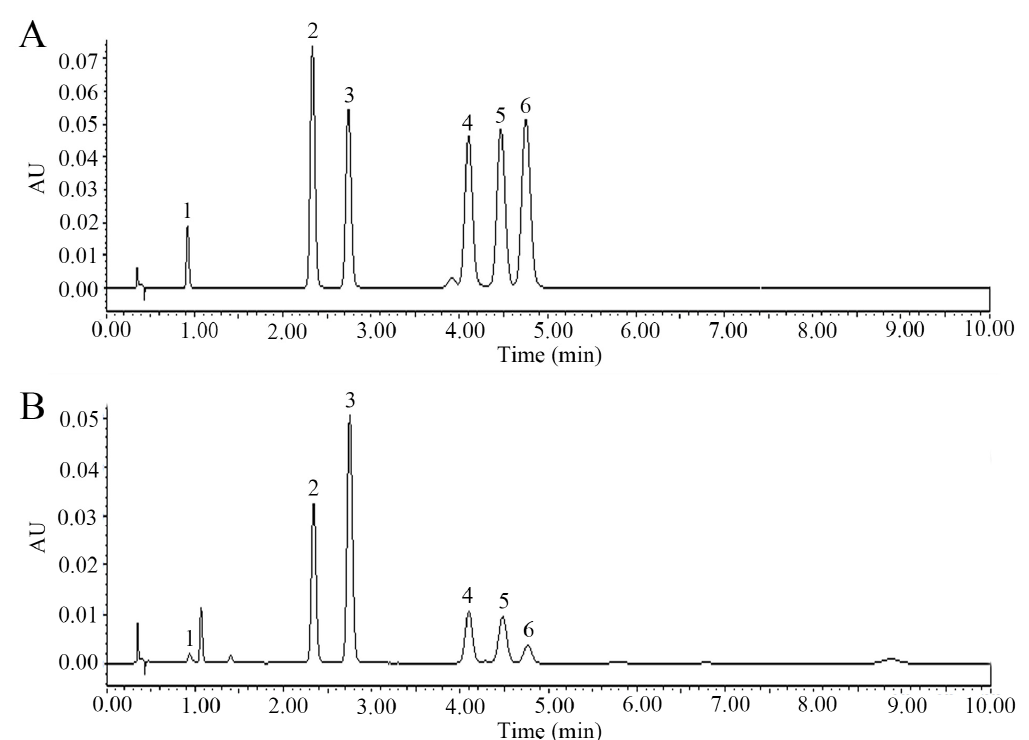
Figure 3. Quantitative analysis of six flavonoids in Smilax glabra flavonoids extract (SGF) by ultra-high-pressure liquid chromatography (UPLC). ( A ) Standards (purity ≥ 98%); ( B ) SGF sample. Compounds 1 , 2 , 3 , 4 , 5 and 6 represent for ( − )-epicatechin, neoastilbin, astilbin, neoisoastilbin, isoastilbin and engeletin,